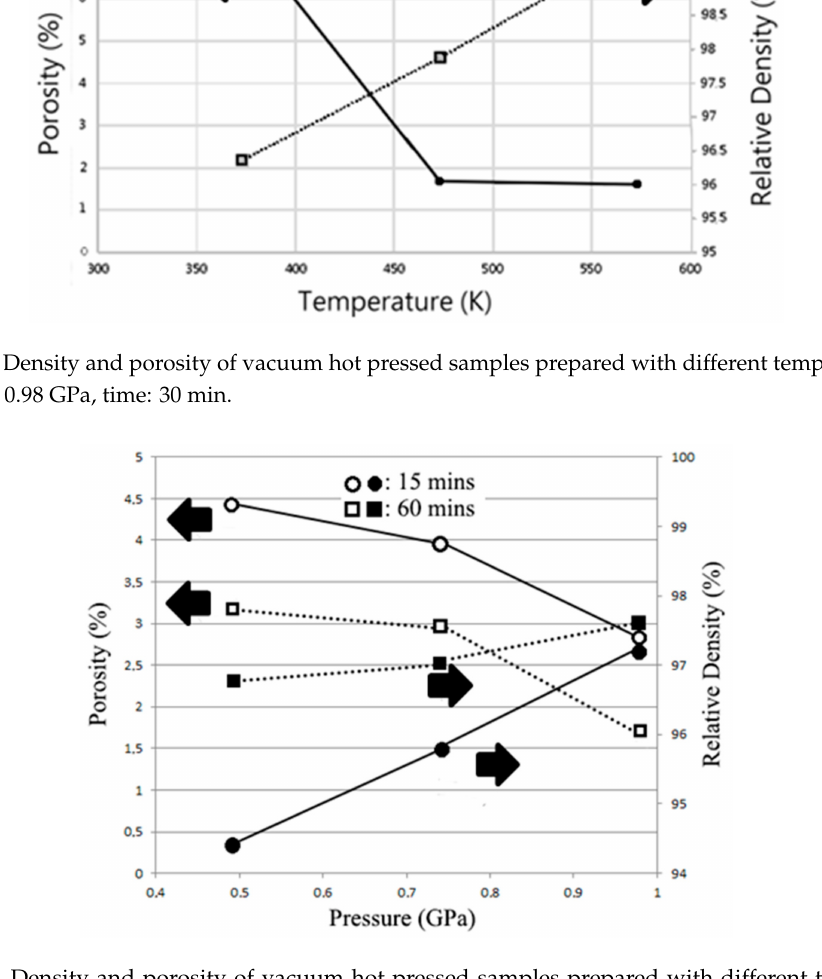
Figure 7. Density and porosity of vacuum hot pressed samples prepared with different time and pressure. Pressure: 0.98 GPa, time: 30